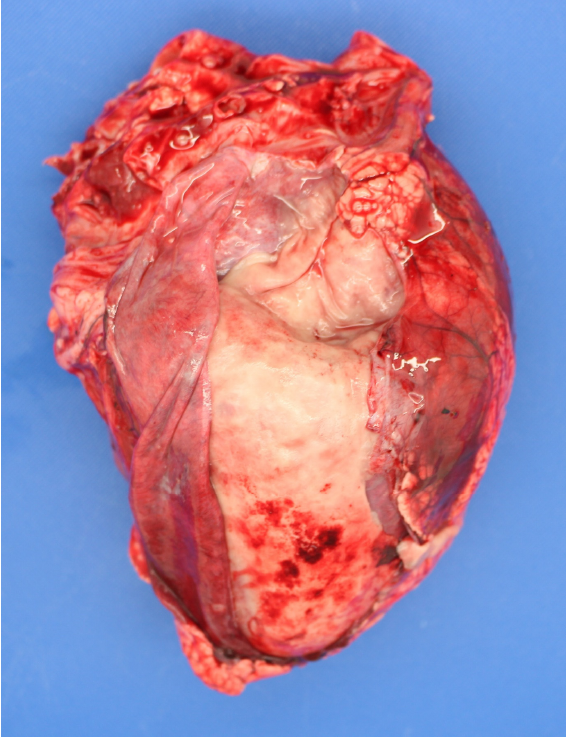
Figure 1. Extensive fibrinous pericarditis in a perinate infected with Bacillus licheniformis. Bovine Viral Diarrhoea Virus (BVDv) Bovine viral diarrhoea virus has generally been detected in <10% of PM cases. How- ever, the virus can also cause serious outbreaks of PM [7] and was one of the original pathogens associated with ‘weak calf syndrome’ [41]. It is more commonly detected in